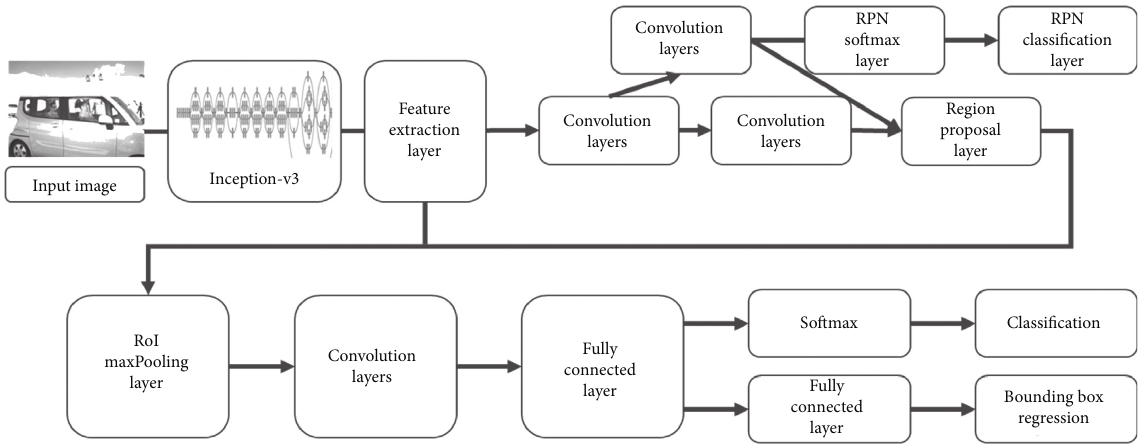
Figure 4: Description of Faster RCNN for one side